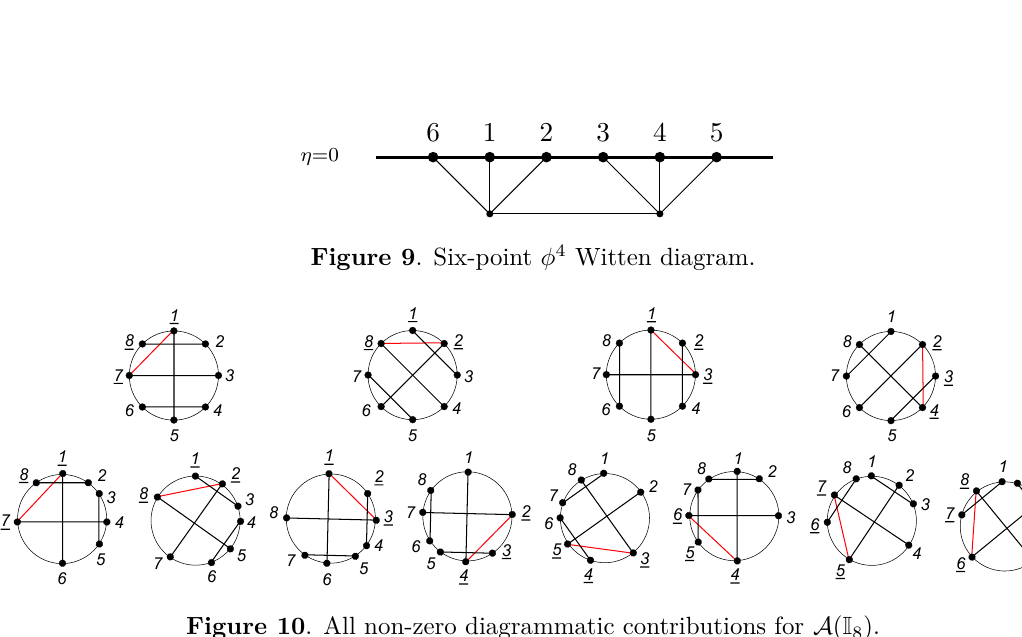
Figure 10 . All non-zero diagrammatic contributions for A ( I 8 )